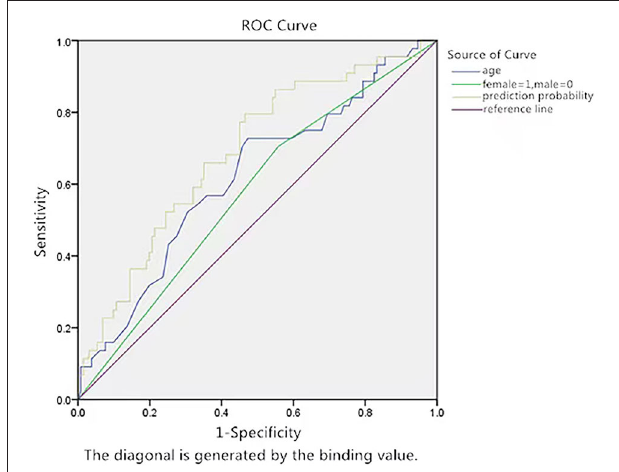
FIGURE 4 | ROC curve of the predictive value of age for syncope recurrence by prediction probability. The y-axis represents the sensitivity to predict syncope recurrence. The x-axis represents the false positive rate (1-specificity) of prediction. The green line in the graph is the reference line, which indicates that the sensitivity is equal to the false positive rate. The blue curve is farther from the green line and nearer to the upper left corner of the graph. The area under the curve was 0.688 (95% CI: 0.598–0.777, P <